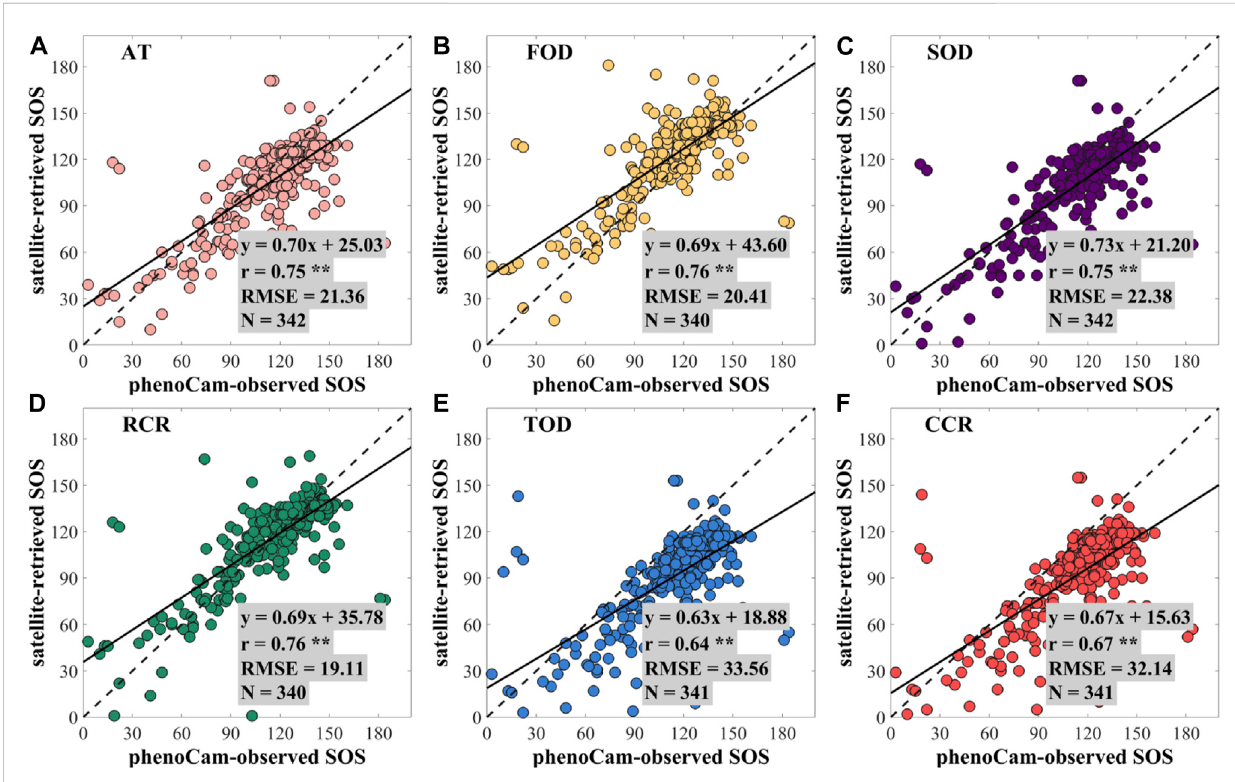
FIGURE 2 Scatterplots for the regression analysis between the PhenoCam-observed SOS and the satellite-retrieved SOS using the methods of (A) amplitude threshold (AT), (B) fi rst-order derivative (FOD), (C) second-order derivative (SOD), (D) relative change rate (RCR), (E) third-order derivative (TOD), and